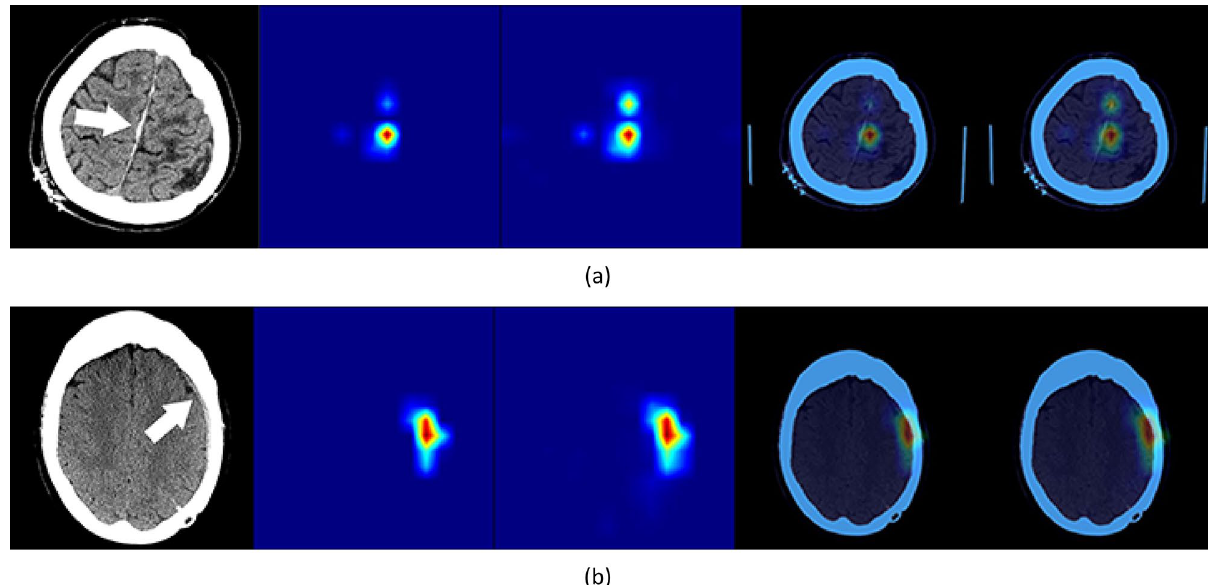
Figure 7. ( a , b ) Two examples of SDH that were missed by a radiologist but detected by the ML model. Visualization of feature maps from layer 4 (the layer before adaptive averaging pooling) in SE-ResNeXt-50 (32 × 4d). Left: Input head CT image; Middle left: GradCAM heat map; Middle: GradCAM++ heat map; Middle right: GradCAM result superimposed on CT image; Right: GradCAM++ result superimposed on CT image. The arrows indicate the